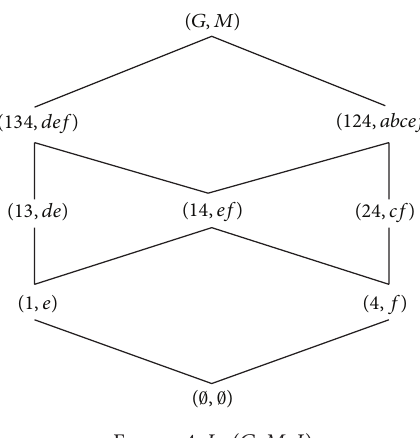
Figure 4: 𝐿 𝑂 (𝐺, 𝑀, 𝐼) .